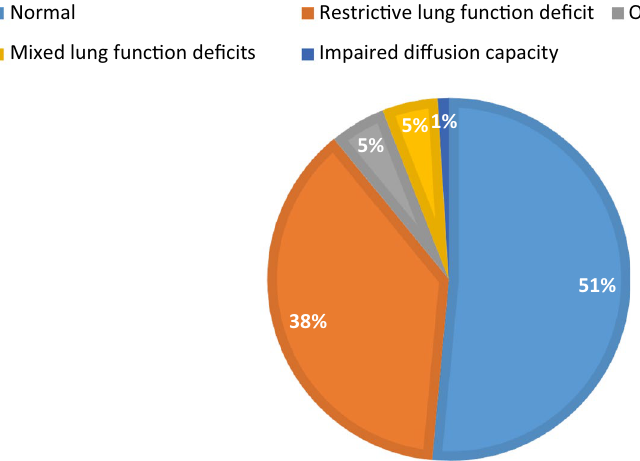
Figure 1. Lung function patterns of patients with transfusion-dependent